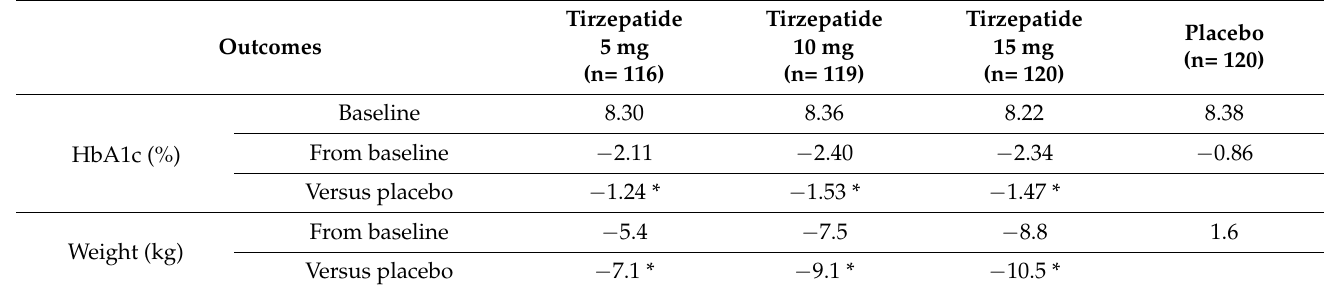
Table 5. Results of the SURPASS-5 at 40 weeks [56]. Efficacy analyses were performed in the mITT population; * p <